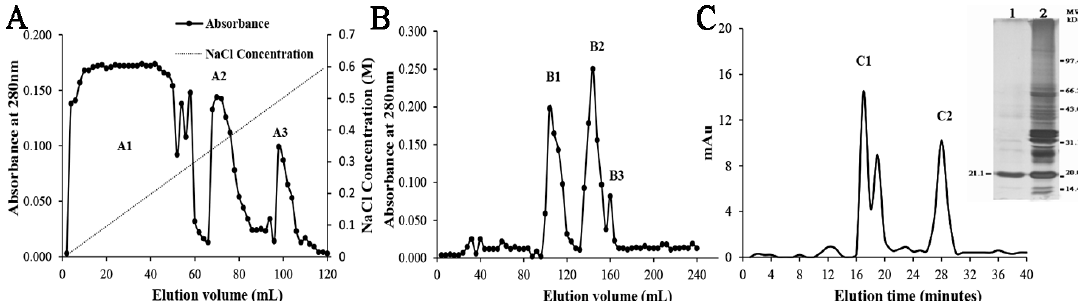
Figure 1. Purification of BanTLP. ( A ) Ion-exchange chromatography of the fraction of banana fruit extract (crude banana extract) with DEAE–Sephadex chromatography A50. The target protein was only observed in fraction A1. ( B ) Gel filtration of fraction A1 by fast protein liquid chromatography on a Sephadex G50 column. The target protein was observed in fractions B2 and B3. ( C ) The active fractions from gel filtration were pooled and used in a reverse-phase Supelco C5 column. The target protein was observed in fraction C2. (Insert) SDS-PAGE profiles of purified antifungal protein from banana fruit visualized using a silver-staining technique. Lane 1: the target protein; Lane 2: crude banana extract. Numbers on the right refer to molecular mass markers. MW represents the molecular weight marker. Table 1. Protein yields at different stages of purification of thaumatin-like protein from banana (BanTLP). Fraction Total Protein from 1.5 kg Flesh (mg) Crude extract Unbound fraction from DEAE–Sephadex A50 Major peak from Sephadex G50 chromatography After reversed-phase